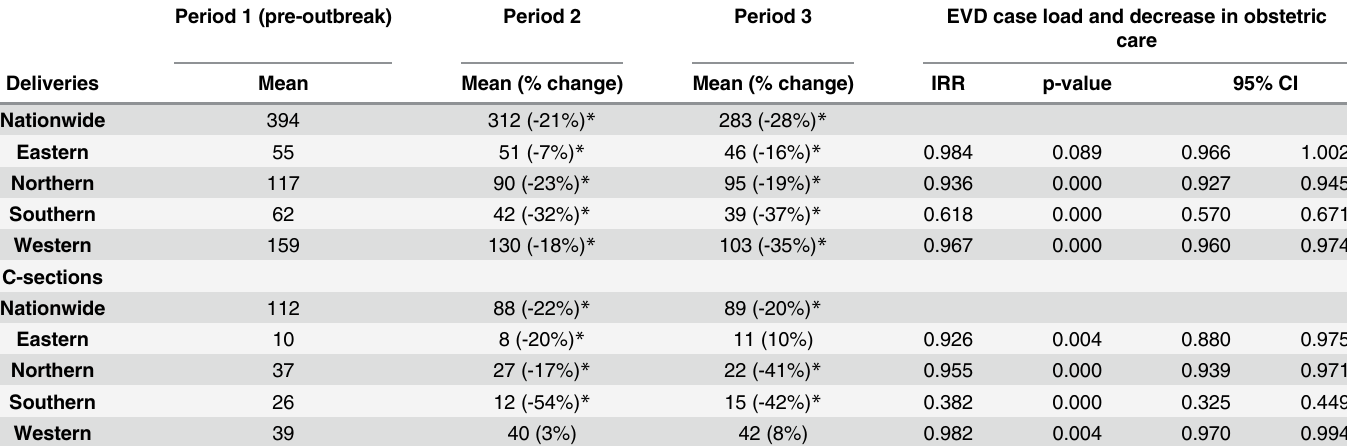
Table 1. In-hospital deliveries and C-sections in Sierra Leone and association of EVD case load and decrease in in-hospital deliveries and C-sec- tions. N = 32. Period 1